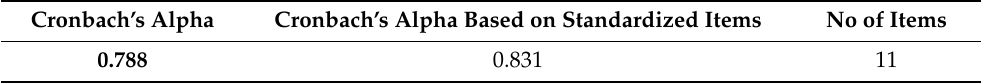
Table 4. Cronbach’s Alpha score for the reliability of the questionnaire.